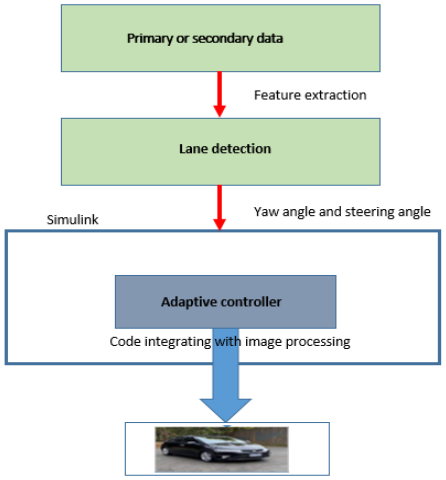
Figure 11. Working procedure of the lane detection algorithm.